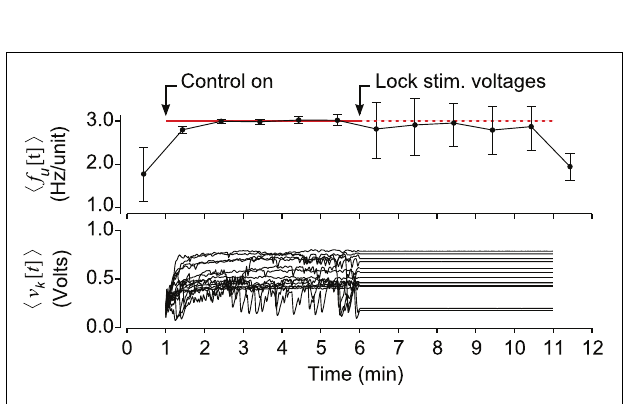
FIGURE 6 | Closed-loop stimulation is required to robustly clamp population firing. (Top)The average neuronal firing rate over 1min periods across 15 trials. Half-way through a multichannel population clamp protocol, real-time voltage updates stop and microstimulation is applied in open-loop. Error bars are ± standard deviation. (Bottom)The mean electrode stimulation voltage across 10 stimulating electrodes, for each of the 15